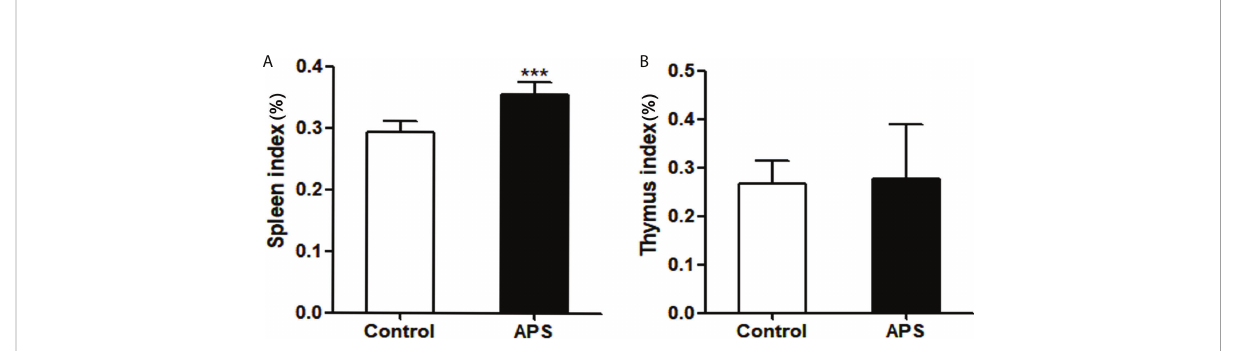
FIGURE 4 The effect of APS in spleen index and thymus index on mice. Mice were euthanized after 8 weeks of Control/APS-treated. (A) Final Spleen index (***p<0.001). (B) Final Thymic index. n=6, Data are expressed by mean ±